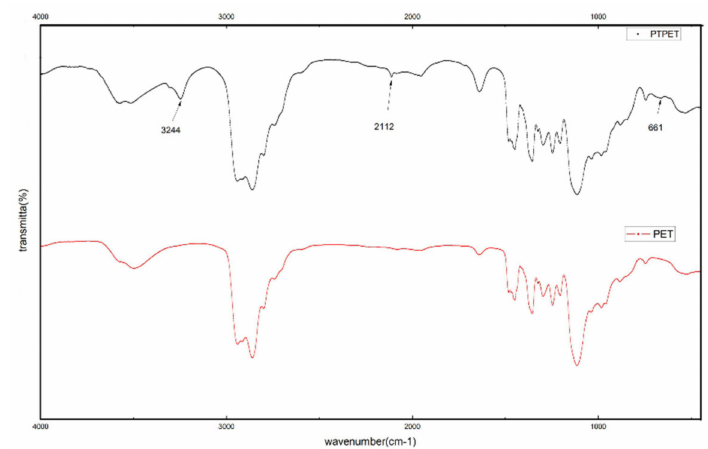
Figure 1. FTIR spectra of PET and PTPET. PET, ethylene oxide-tetrahydrofuran copolymer; PTPET, propargyl-terminated ethylene oxide-tetrahydrofuran